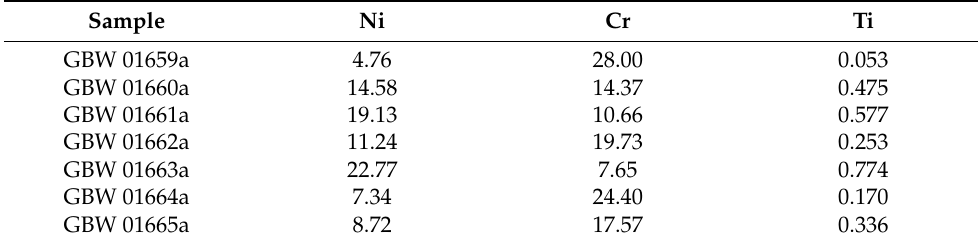
Table 2. Reference content of Ni, Cr, and Ti in the samples